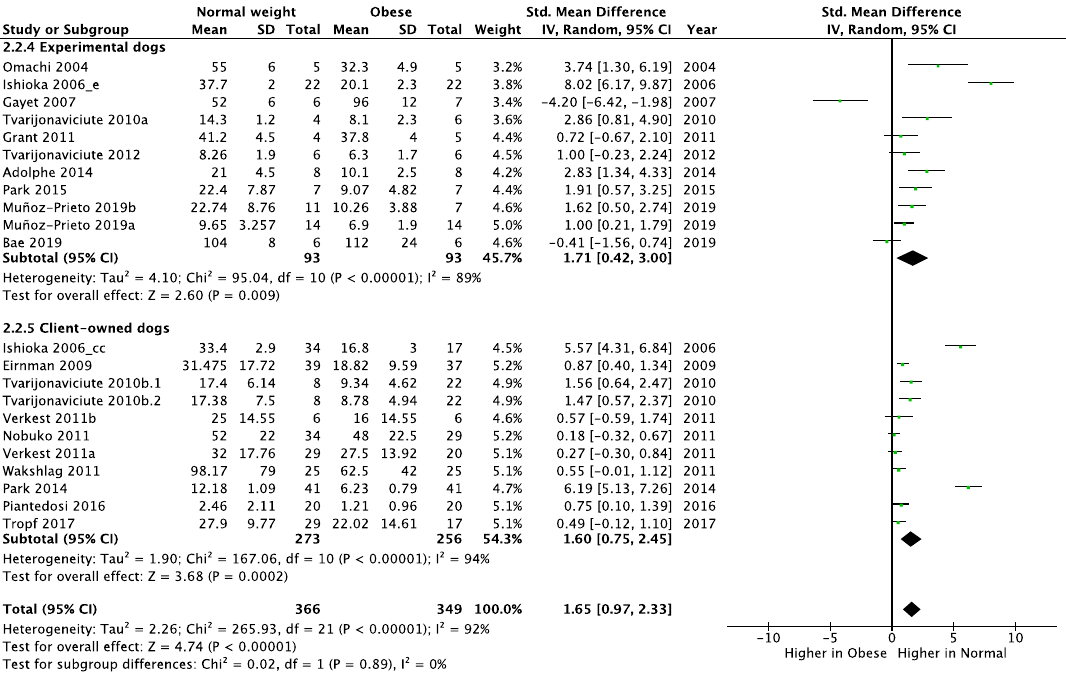
Figure 5. Subgroup (experimental and client-owned dogs) meta-analysis of circulating total adiponectin concentrations in obese versus normal weight dogs. SD: Standard deviation; Std: Standardized; IV: Interval variable; CI: Confidence interval.